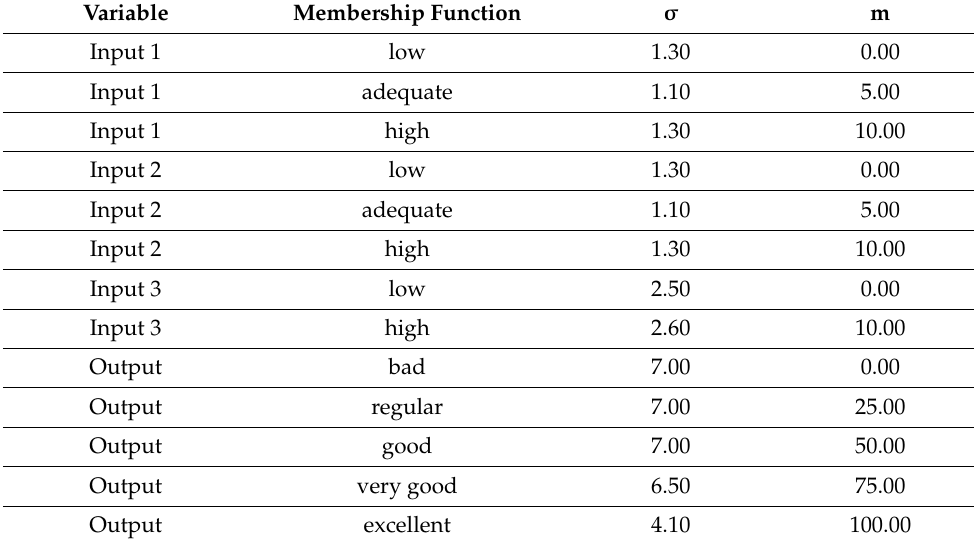
Table 2. Parameter values for the Gaussian MFs used in the linguistic values.